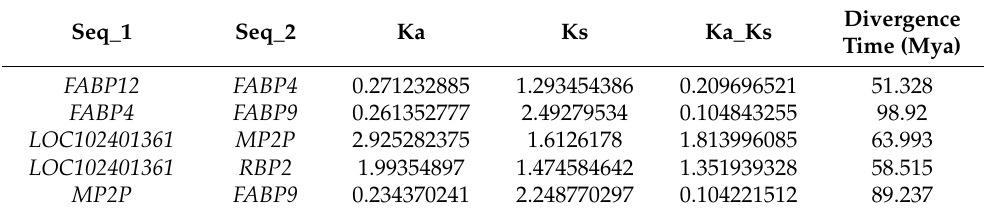
Table 2. Ka/Ks ratios estimated in the present work for duplicated FABP genes in buffalo.